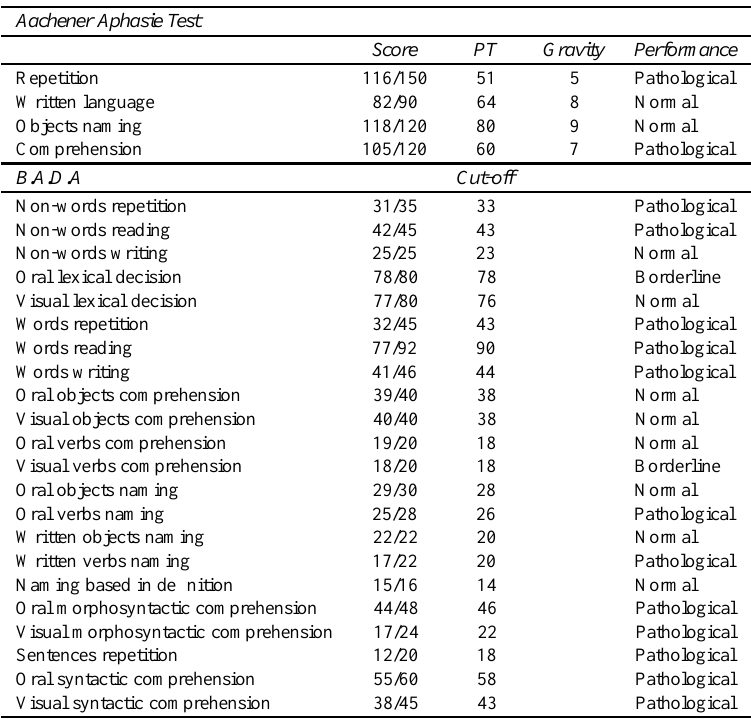
Table 2 Language assessment (July